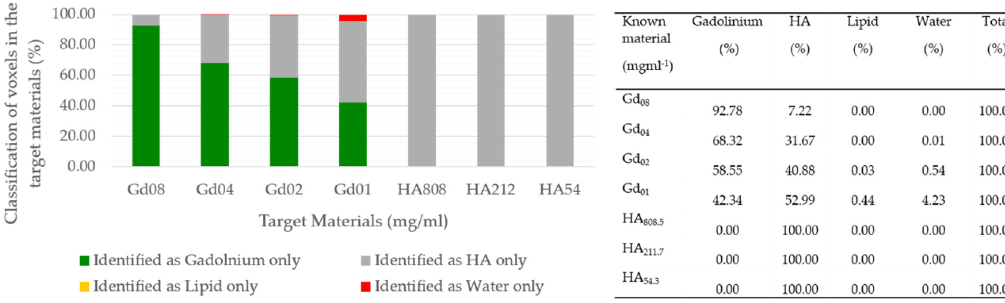
Figure 10. MD identification chart for protocol ‐ 1 shows quantitative misidentification of voxels between gadolinium, hydroxyapatite, lipid, and water. For the 8 mg Gd/mL solution insert, not a single voxel was misidentified (100% sensitivity) as a different material. For 4 mg Gd/mL, ~98% voxels were correctly identified as gadolinium and 2% were misidentified as HA. Similarly, for 1 mg Gd/mL solution insert, ~62% voxels were identified as gadolinium, ~18% were misidentified as HA, ~10% misidentified as lipid and water. For HA calibration rods, no misidentification is observed for 808 mg HA/mL and 212 mg HA/mL but ~4% voxels from 54 mg HA/mL was misidentified as Gd. A corresponding table in the right is shown to look up individual value in the chart.